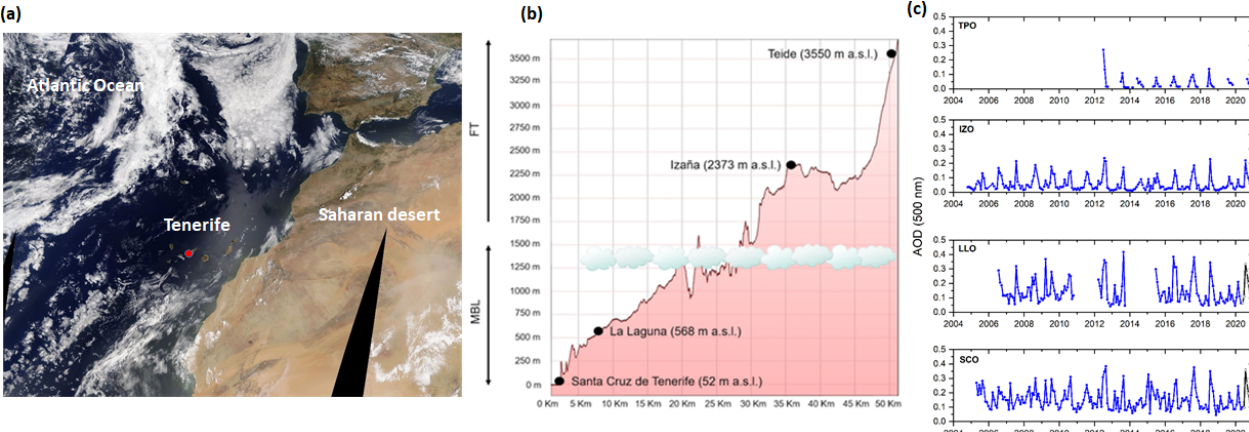
Figure 1. (a) MODIS visible imagery on 26 August 2021 over western Africa and the northern Atlantic Ocean. The red dot indicates the location of the island of Tenerife. Image credit: NASA Worldwide (https://worldview.earthdata.nasa.gov, last access: 22 March 2022). (b) The elevation profile of Tenerife, indicating the corresponding elevations of the four stations (SCO, LLO, IZO and TPO) and their locations with respect to the marine atmospheric boundary layer (MABL) and the free troposphere (FT). The stratocumulus cloud top is limited by trade wind inversion. (c) Time series of the monthly mean AOD at 500nm at SCO, LLO, IZO and TPO. The blue dots represent AERONET version 3.0 level 2.0 AOD data and the black dots represent level 1.5